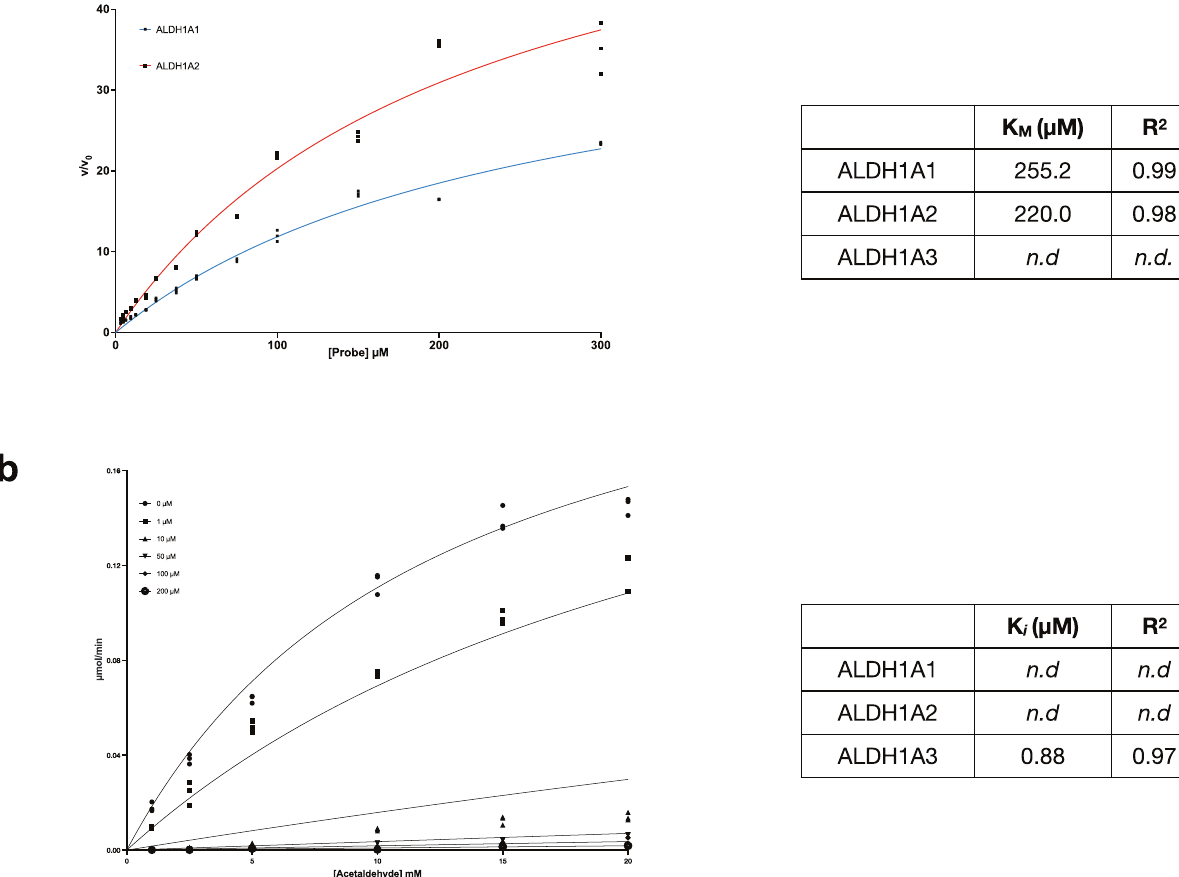
Fig. 3 Kinetic characterization of the interaction of probe 10 with human ALDH1A3. a K M graph and value of the complex between Probe 10 at fi xed concentration and various concentration of ALDH1A1 and ALDH1A2. b K i graph and value of the complex between Probe 10 and ALDH1A3, in presence of different substrate and probe concentration. Probe 10 was analyzed as potential full competitive inhibitor.